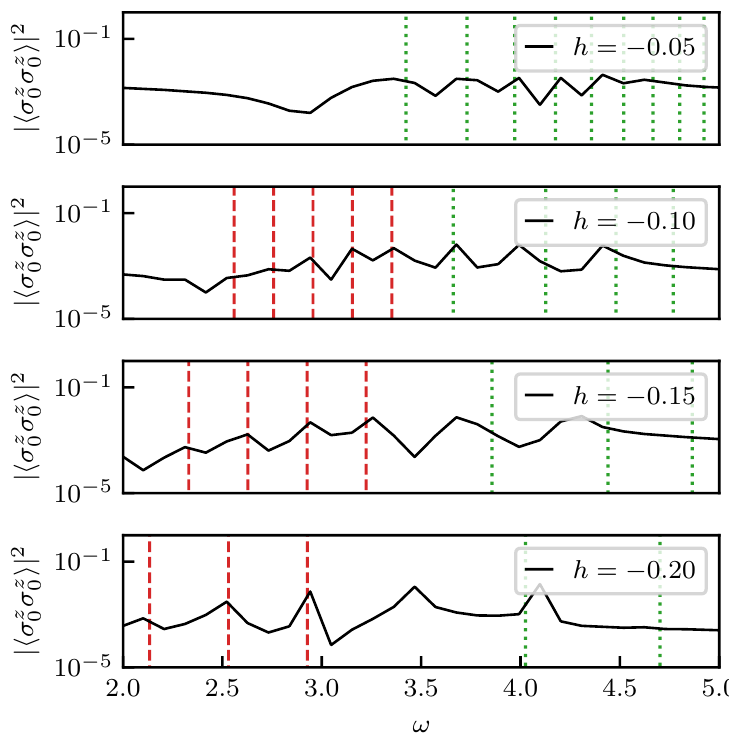
(cid:10) σ z ( t ) σ z ( t ) (cid:11) for l = 0 and g = 0.25. Green dotted 0 l c becomes smaller. In max (from top to bottom) max